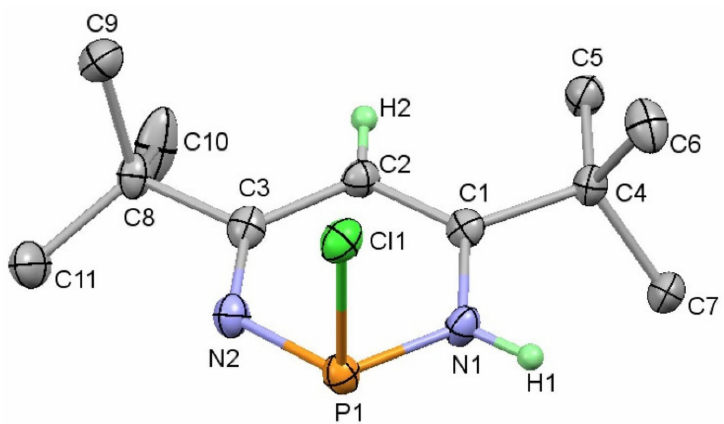
Figure 1. Molecular structure of 2 (thermal ellipsoids at 50%; all H atoms except for those attached to the heterocyclic ring have been omitted for clarity). Selected bond lengths (Å) and angles ( ◦ ): Cl1-P1 2.2417(11); P1-N1 1.689(3); P1-N2 1.653(3); N1-C1 1.377(4); C1-C2 1.359(4); C2-C3 1.432(4); N2-C3 1.320(4); N1-P1-Cl1 99.59(10); N2-P1-Cl1 98.29(10); N2-P1-N1